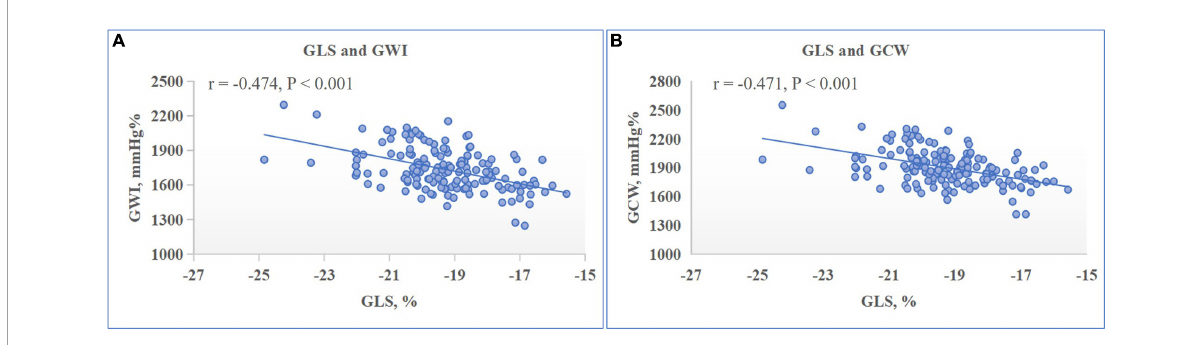
FIGURE3 Relationship between left ventricular (LV) myocardial work indices and LV global longitudinal strain (GLS). Scatter plot presented the significantly negative correlation between LV global work index (GWI) (A) and global constructive work (GCW) (B) with LV GLS.